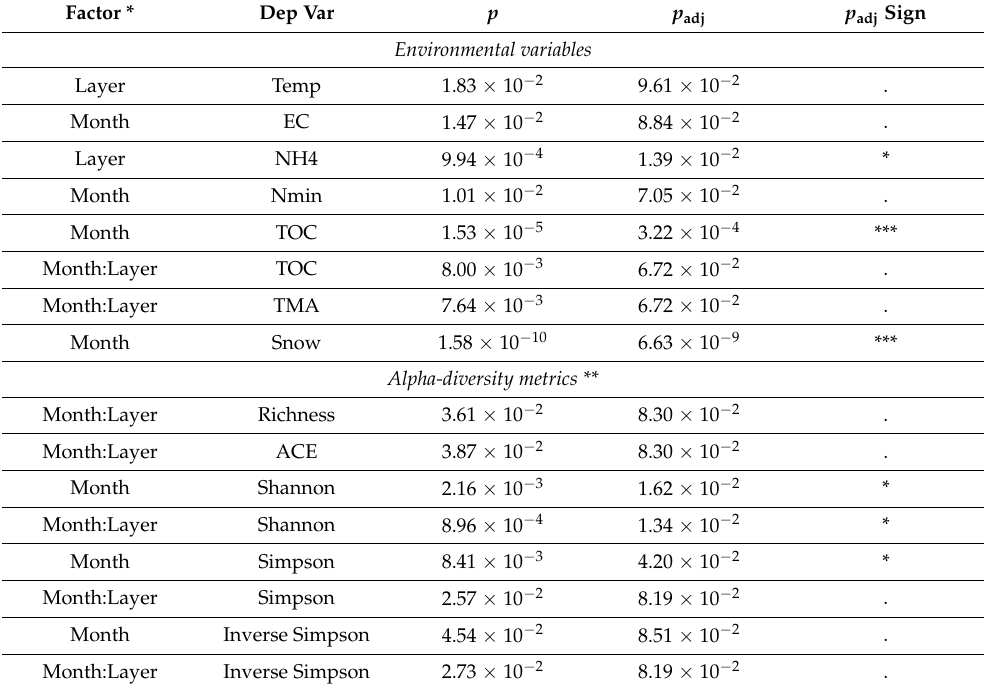
Table 4. Two-way ANOVA with interaction of factors computed for environmental variables and alpha-diversity metrics.